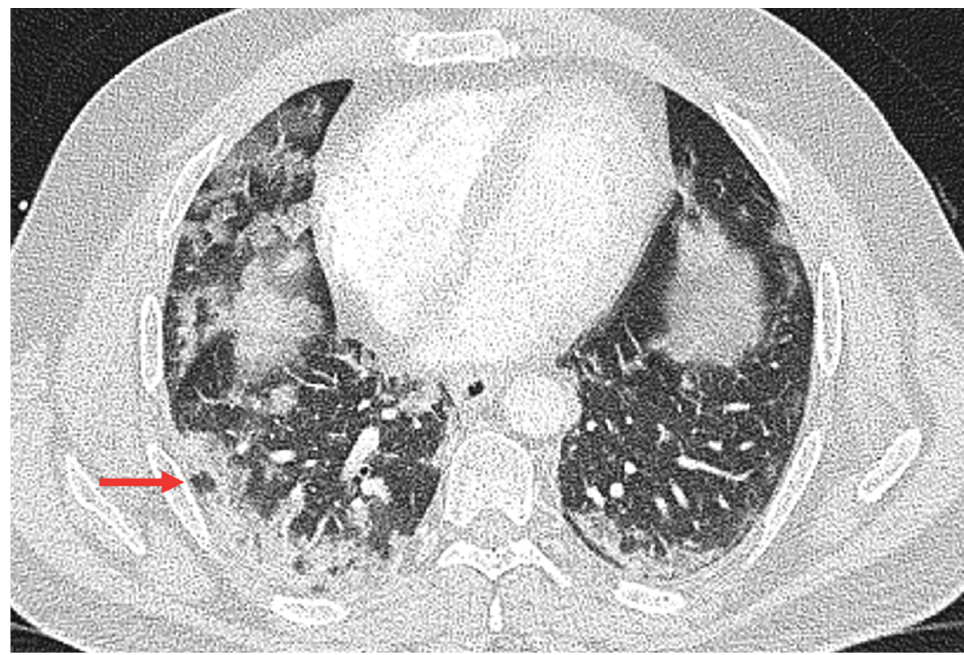
Figure 2. Vacuolar sign (red arrow) in right lower lobe in a 44-year-old male patient with the Delta variant COVID-19